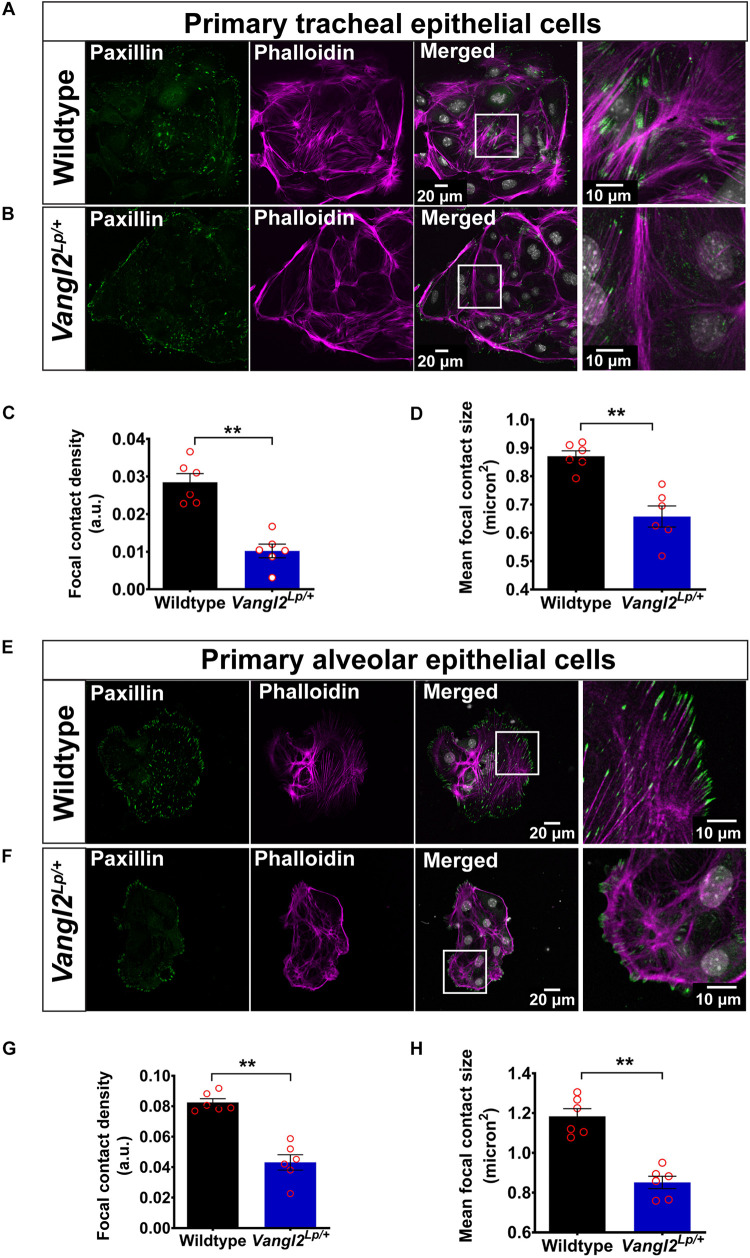
VANGL2 dysfunction leads to highly disrupted actin cytoskeleton and focal adhesions. Representative images showing wildtype (A) and Vangl2Lp/+
(B) TECs labeled with phalloidin (magenta) to visualize F-actin and paxillin (green) to stain focal contacts. Nuclei were stained with DAPI (gray). Quantification of focal contact density (C) and mean focal contact size (micron2) (D) in wildtype and Vangl2Lp/+ TECs. n = 3 independent experiments; TECs from three mice were pooled for each group per experiment; two technical replicates for each group per experiment; images from at least three fields were taken per technical replicate; each dot represents mean value per technical replicate. Mann–Whitney U-test, **p < 0.01. Representative images showing wildtype (E) and Vangl2Lp/+
(F) AECs labeled with phalloidin (magenta) and paxillin (green). Nuclei were labeled with DAPI (gray). Quantification of focal contact density (G) and mean focal contact size (micron2) (H) in wildtype and Vangl2Lp/+ AECs. n = 3 independent experiments; AECs from one mouse per group for each experiment; two technical replicates for each group per experiment; at least three fields were taken per technical replicate; each dot represents mean value per technical replicate. Mann–Whitney U-test, **p < 0.01. All data are presented as mean ± SEM.